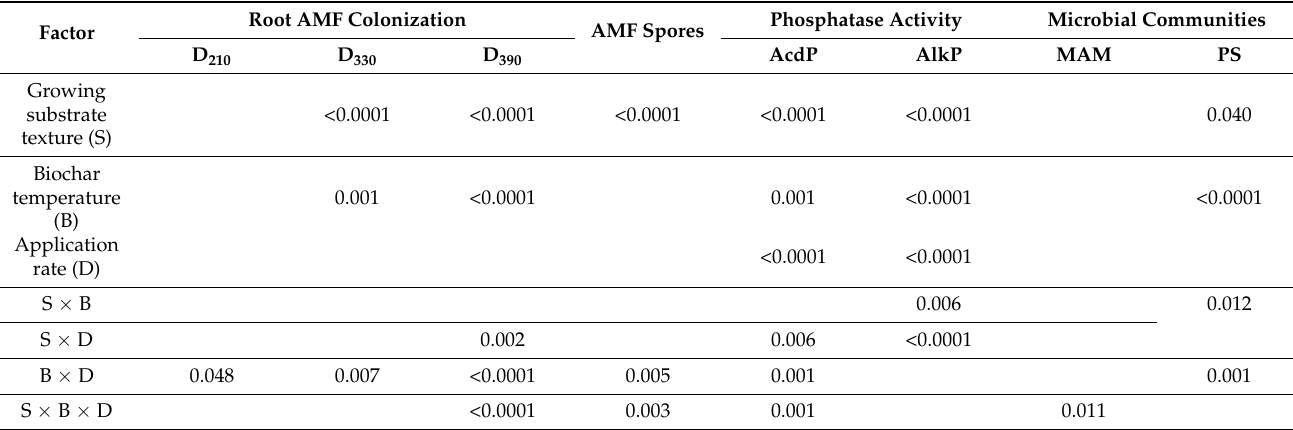
Table 3. Three-way ANOVA results on the effects of growing substrate texture, biochar temperature and application rate on root AMF colonization, number of AMF spores, phosphatase activities and microbial communities. Phosphatase Activity Microbial Communities